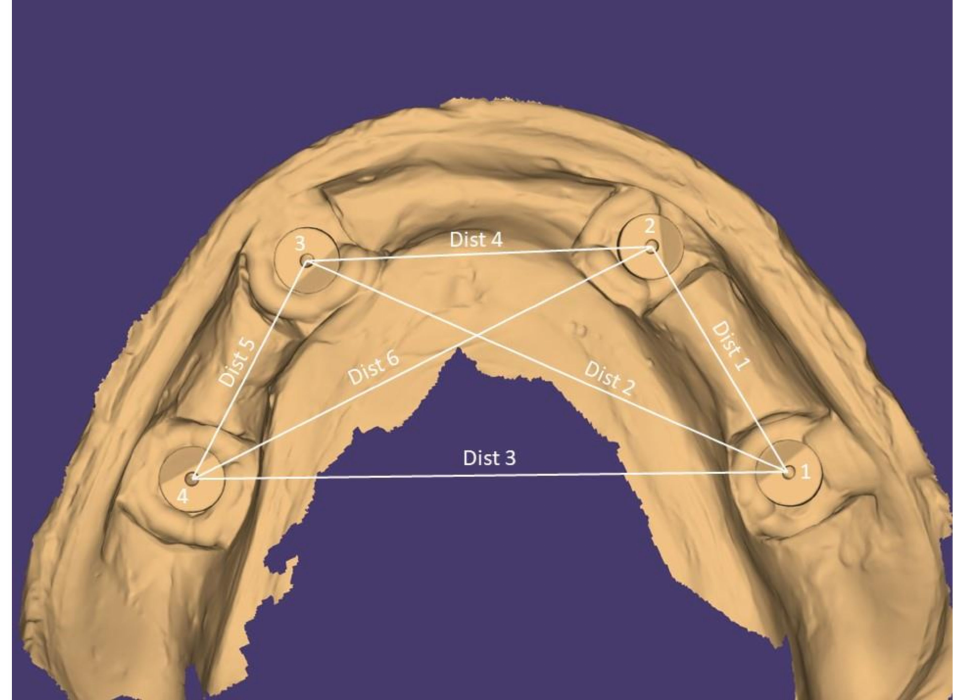
Figure 2. Digital impression with the scan posts and their centroids. Distances and number of each implant for the master model are